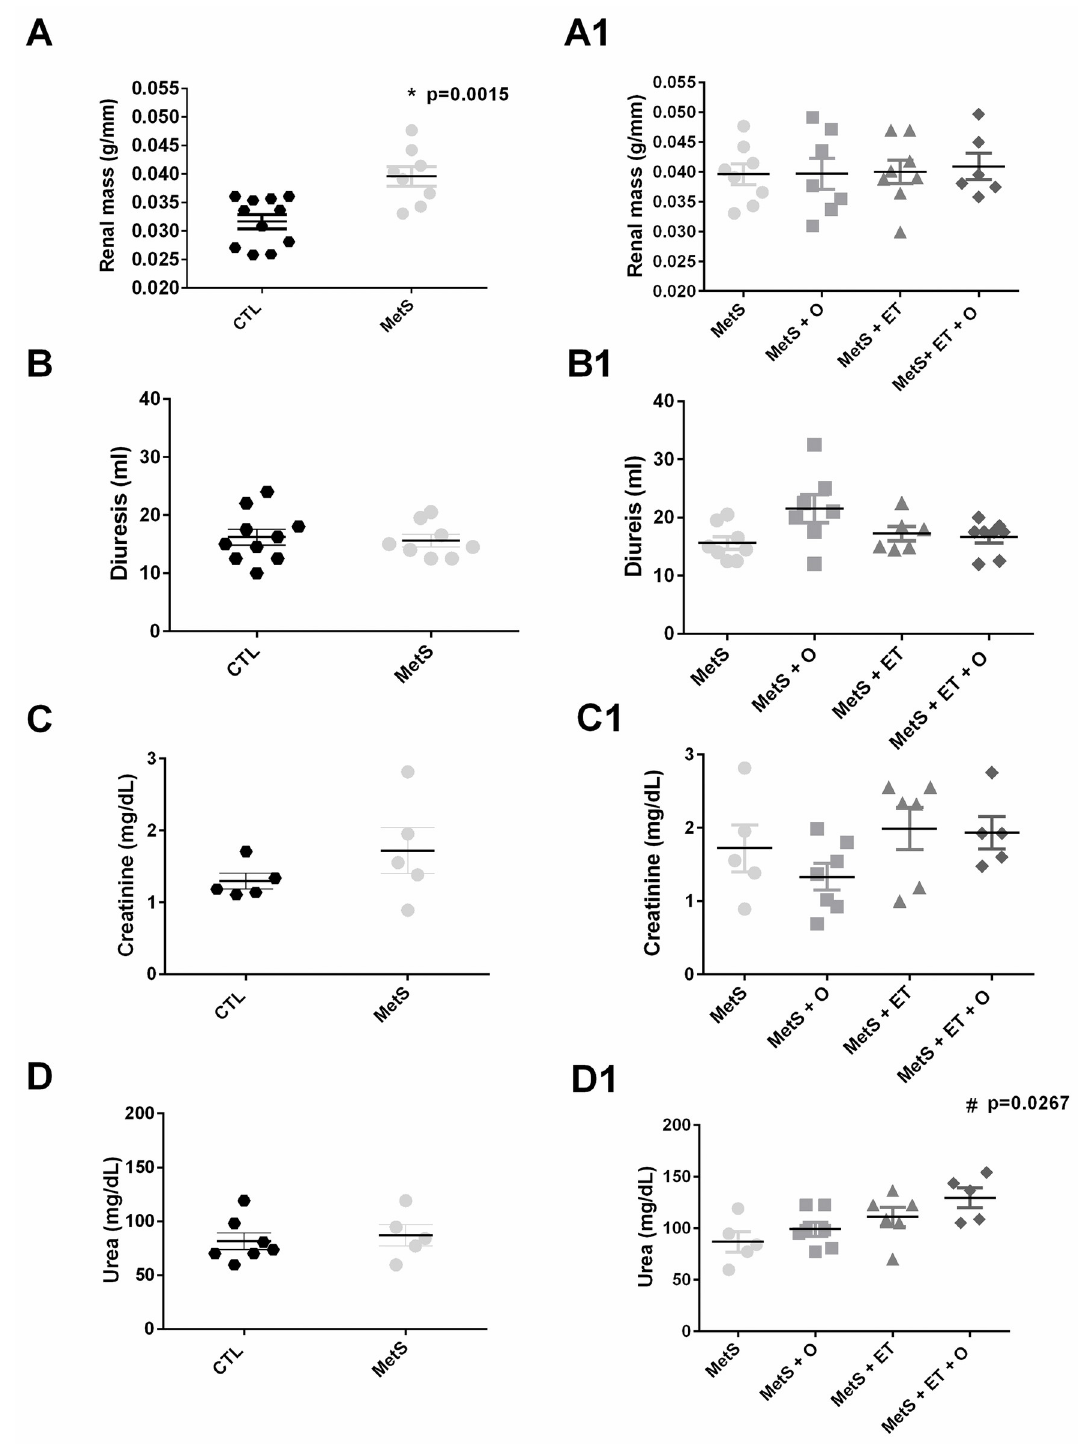
Fig 4. Analysis of renal function. (A/A1) Renal mass (p = 0.0015), (B/B1) Diuresis, (C/C1) Creatinine, (D/D1) Urea (p = 0.0267). #vs. MetS. Statistic: One-Way ANOVA, p < 0.05.